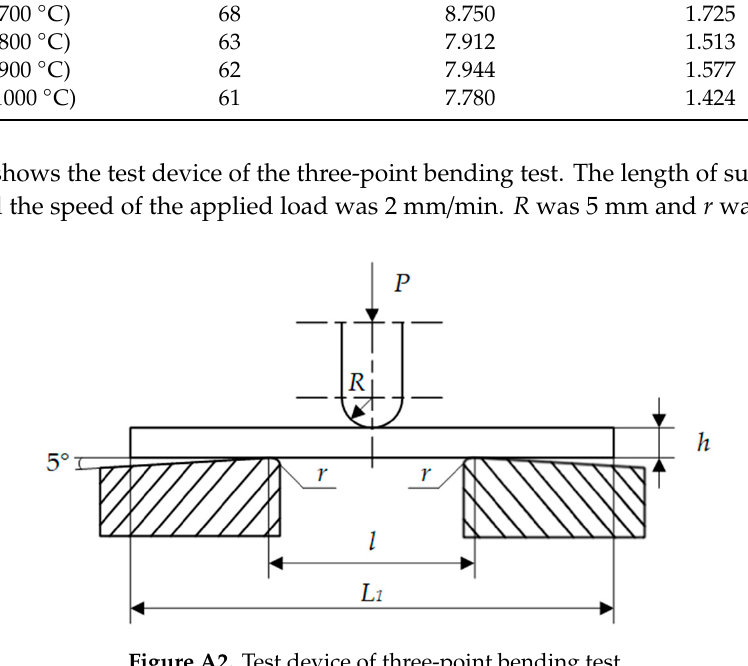
Figure A2. Test device of three-point bending test.